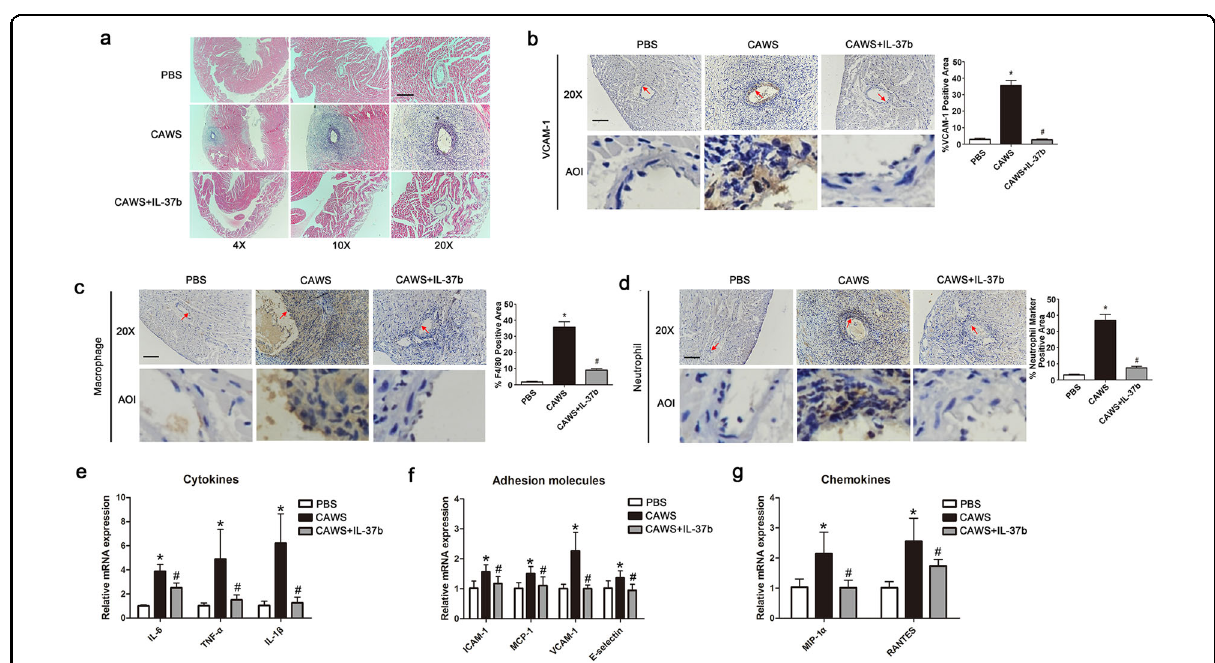
Fig. 2 The coronary arteritis was mitigated after Il-37b injection in a KD mouse model. a Representative images from H&E staining at 28-day post-CAWS injection. Magni fi cation: ×200. Scale bar = 100 μ m. b – d The expression levels of vascular cell adhesion molecule 1 (VCAM-1), macrophage marker F4/80, and neutrophil marker were, respectively, determined using IHC staining in the endothelium of coronary arteries. Enlarged images of area of interesting (AOI) were indicated with a red arrow. Scale bar = 100 μ m. e – g The expression levels of cytokines, adhesion molecules, and chemokines were detected in the mice heart section. Signi fi cance: * P < 0.05 vs. the PBS group, and # P < 0.05 vs. the CAWS group. N = 6 mice per group, and each experiment was conducted at least three